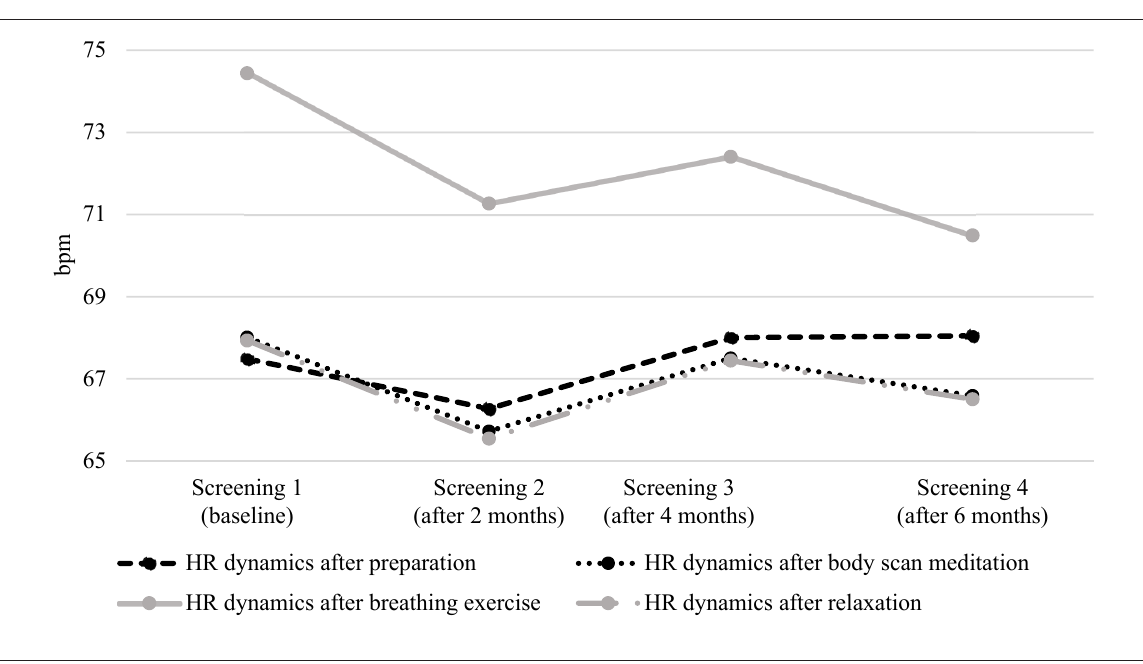
Figure 2. HR dynamics during 6-month period